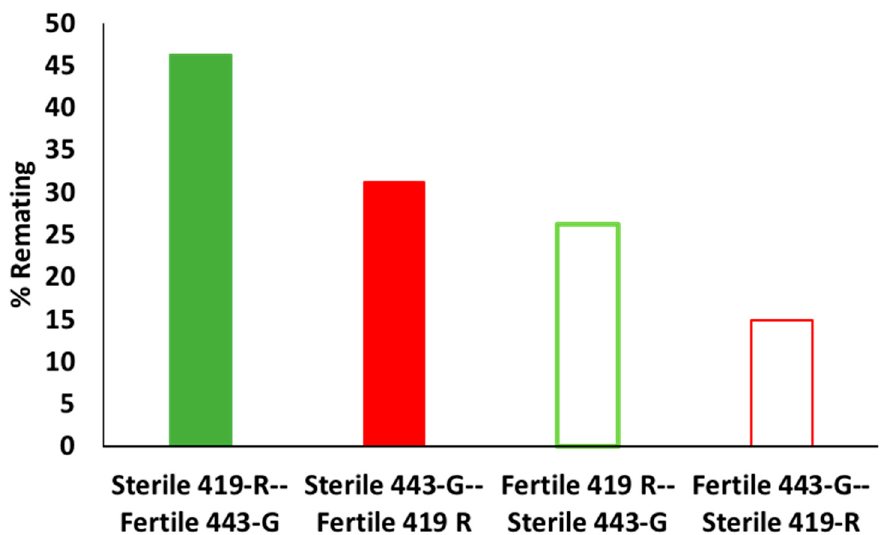
Figure 6. Percentage of A. ludens females remating. Matings where first with either a sterile 419-R male and then a fertile 443-G male (green bar); a fertile 419-R and then a sterile 443-G male (open green bar); a sterile 443-G male and then a fertile 419-R male (red bar); or a fertile 443-G and then a sterile 419-R male (open red bar).